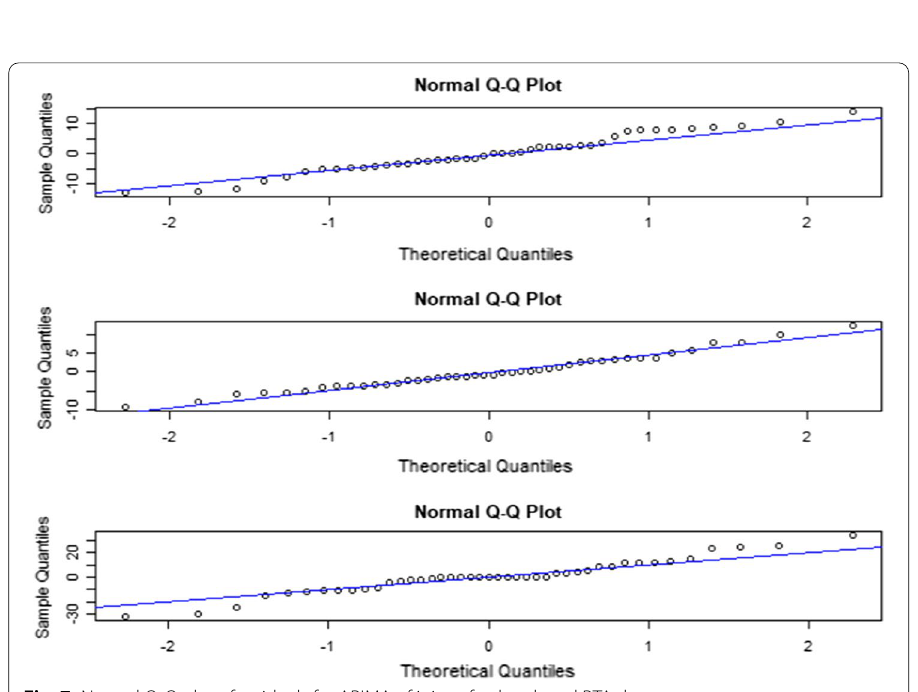
Fig. 7 Normal Q-Q plot of residuals for ARIMA of injury, fatal and total RTA